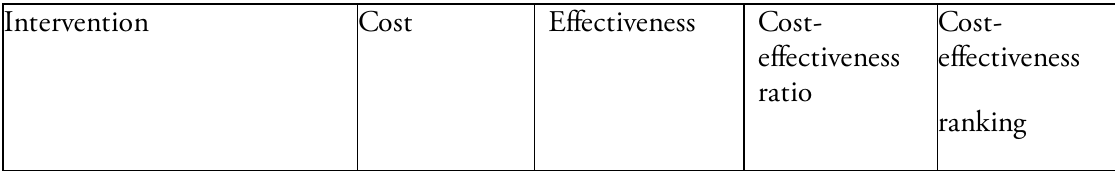
Table 14: Cost-effectiveness analysis of specified PM10 reduction interventions